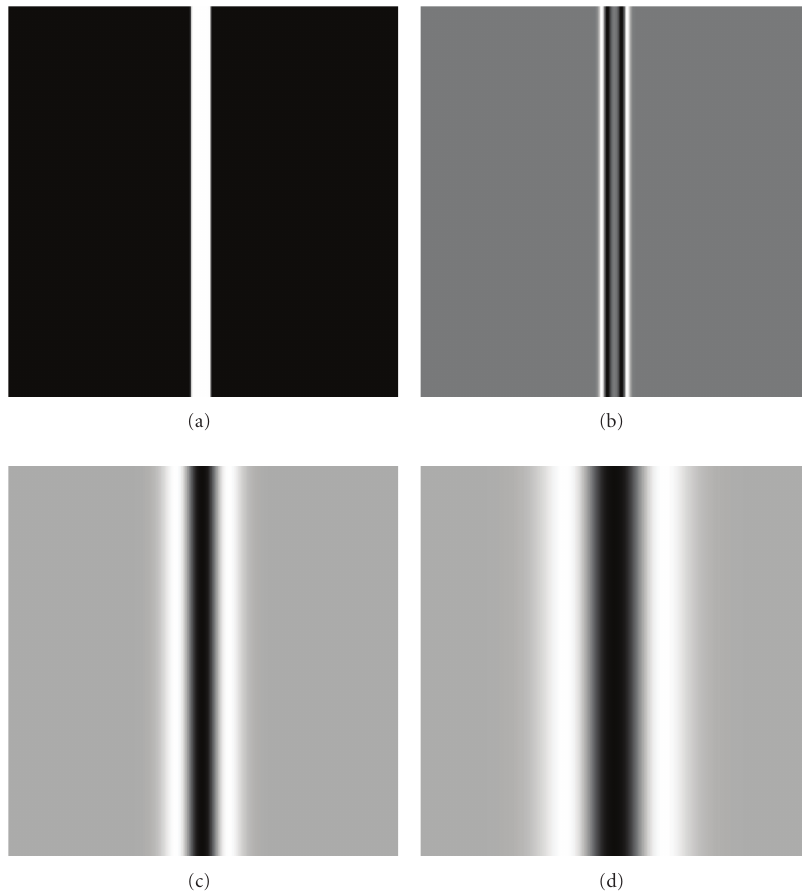
Figure 5: Original image convolved with second-order Gaussian derivatives. (a) Original image having an object with bar-like intensity profile of size 2 σ = 10. (b) Original image convolved with second-order Gaussian derivative of kernel size σ = 1. (c) Original image convolved with second-order Gaussian derivative of kernel size σ = 5. (d) Original image convolved with second-order Gaussian derivative of kernel size σ =